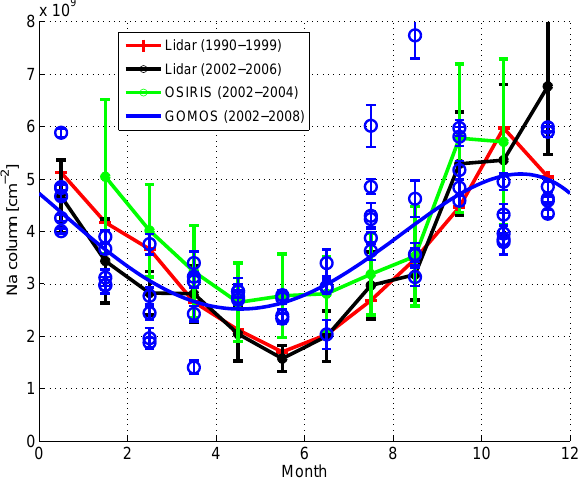
Table 1. Parameters to be used for Eq. (8). A test value